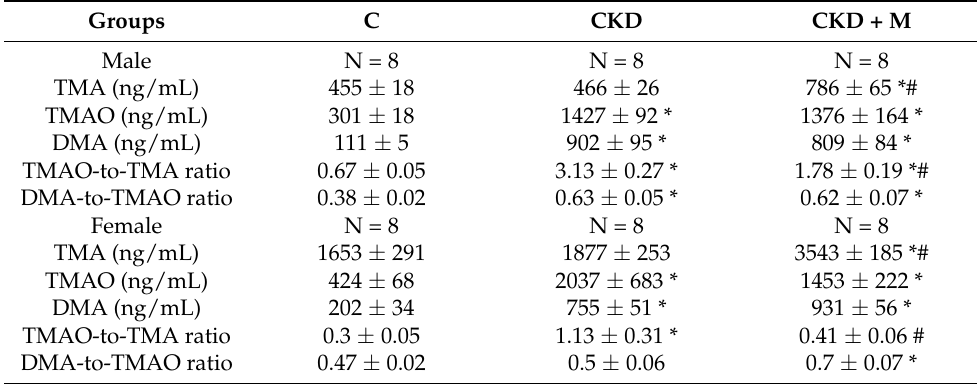
Table 2. Plasma levels of TMA, TMAO and